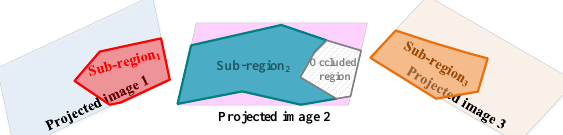
Figure 8. Visible sub-regions of the planar region in the